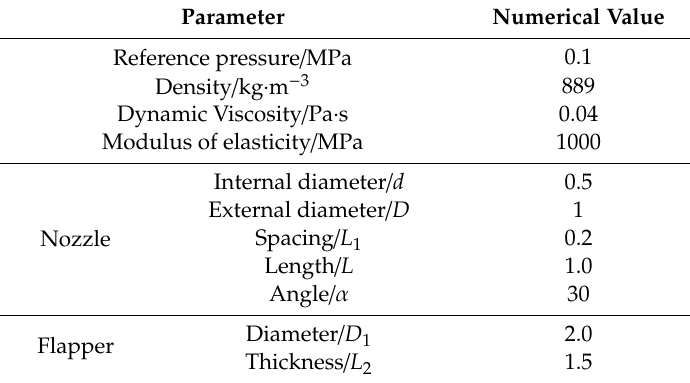
Table 1. Nozzle parameters of the flapper nozzle